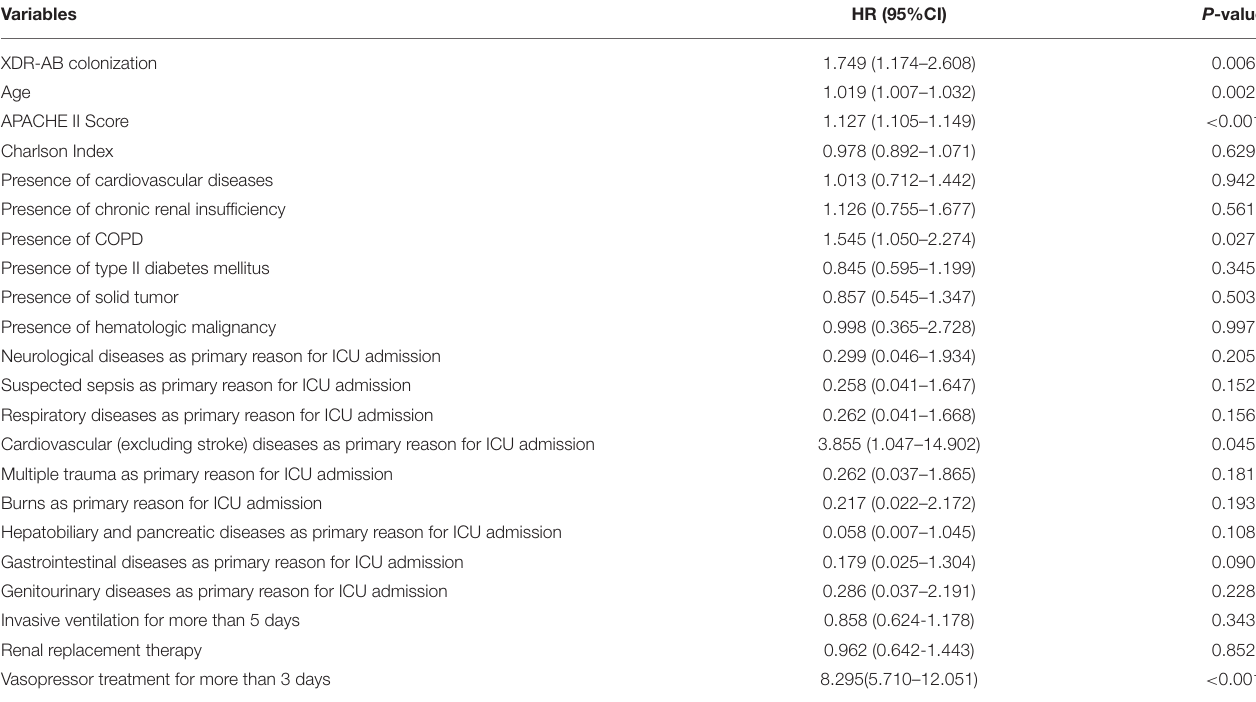
TABLE 5 | Multivariate Cox regression model for Factors Associated with mortality in 6-month (XDR-AB colonization